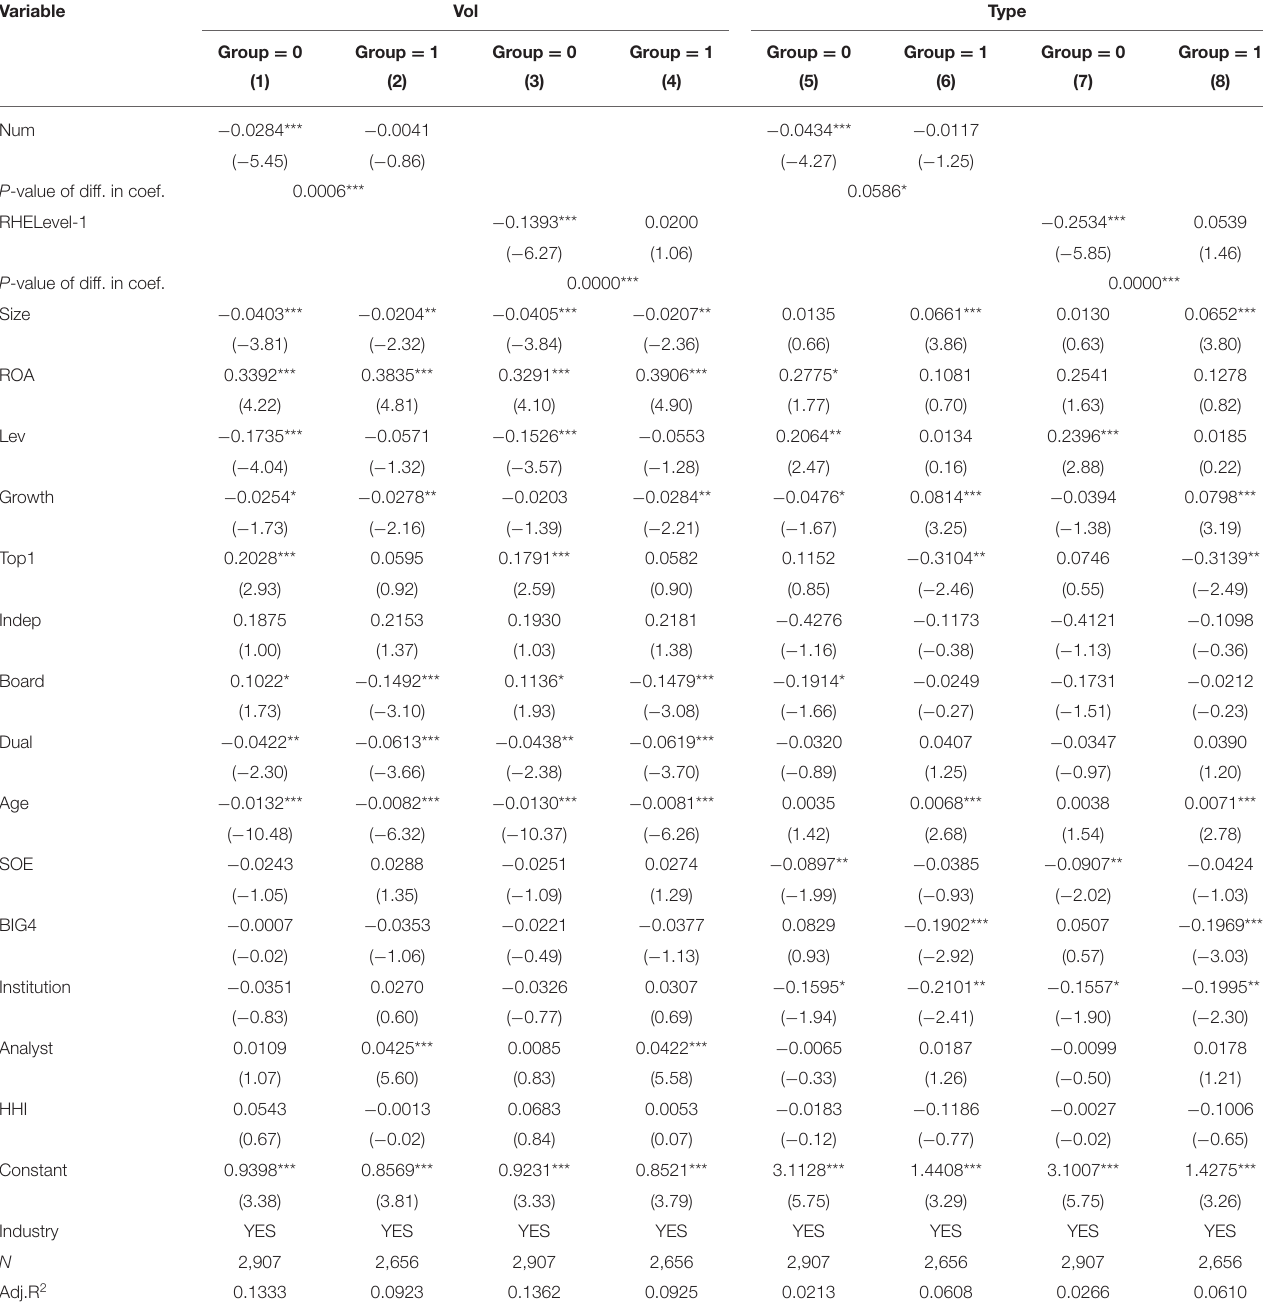
TABLE 4 | Impact of COVID-19 and media scrutiny on management earnings